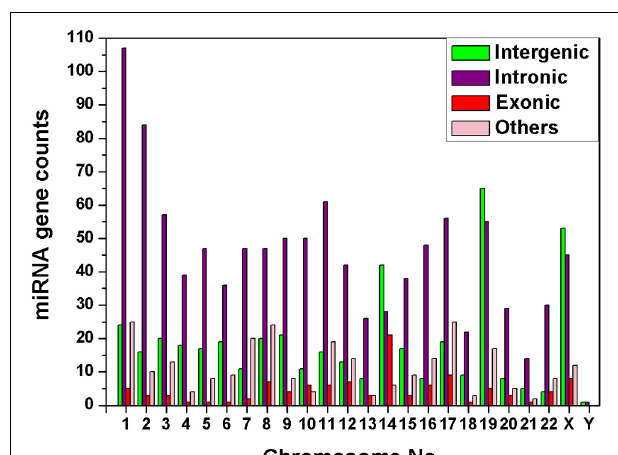
FIGURE 5 | Variation of number of miRNAs associated with cancer and cardiovascular disease in human